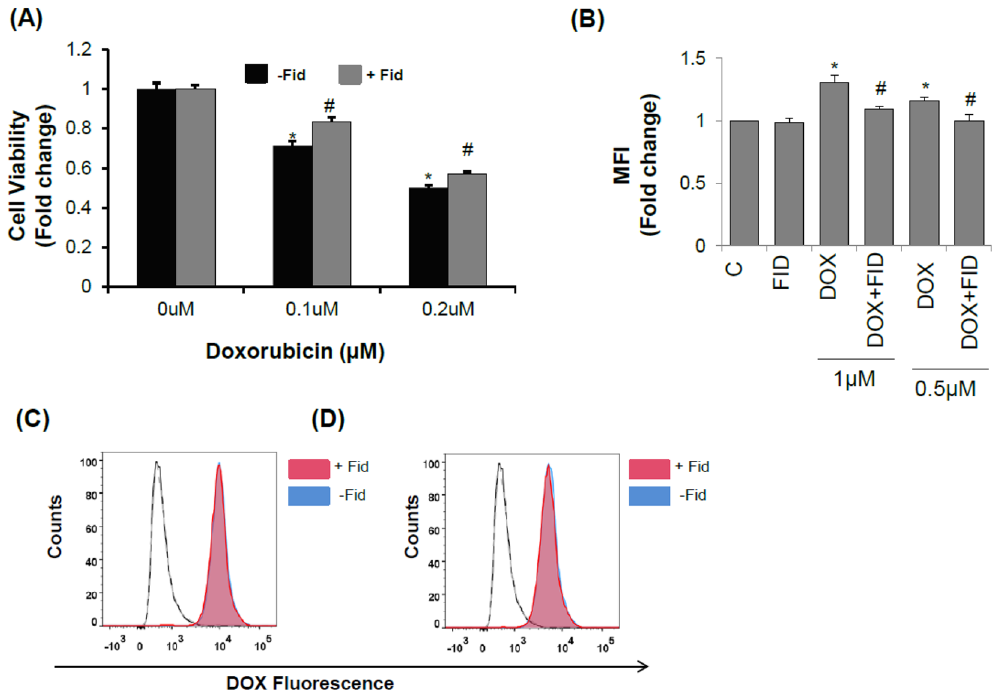
Figure 7. Effect of fidarestat on DOX-treated H9c2 cardiomyocytes: ( A ) Effect of DOX on H9c2 cell viability analyzed by MTT cell viability assay. Values are Mean ± SD (n = 6). ( B ) Effect of fidarestat on DOX- induced ROS production in H9c2 cells treated alone or in combination with fidarestat (n = 3). Doxorubicin accumulation in H9c2 cells treated with ( C ) 0.5 μ M and ( D ) 1 μ M DOX alone or in combination with fidarestat for 24 h. Red filled histogram is DOX in combination with fidarestat and blue filled is DOX alone. Unfilled histogram with a solid line is untreated control and unfilled histogram with dashed line is fidarestat only treated (n = 3). Individual p values are mentioned in the figures (n =